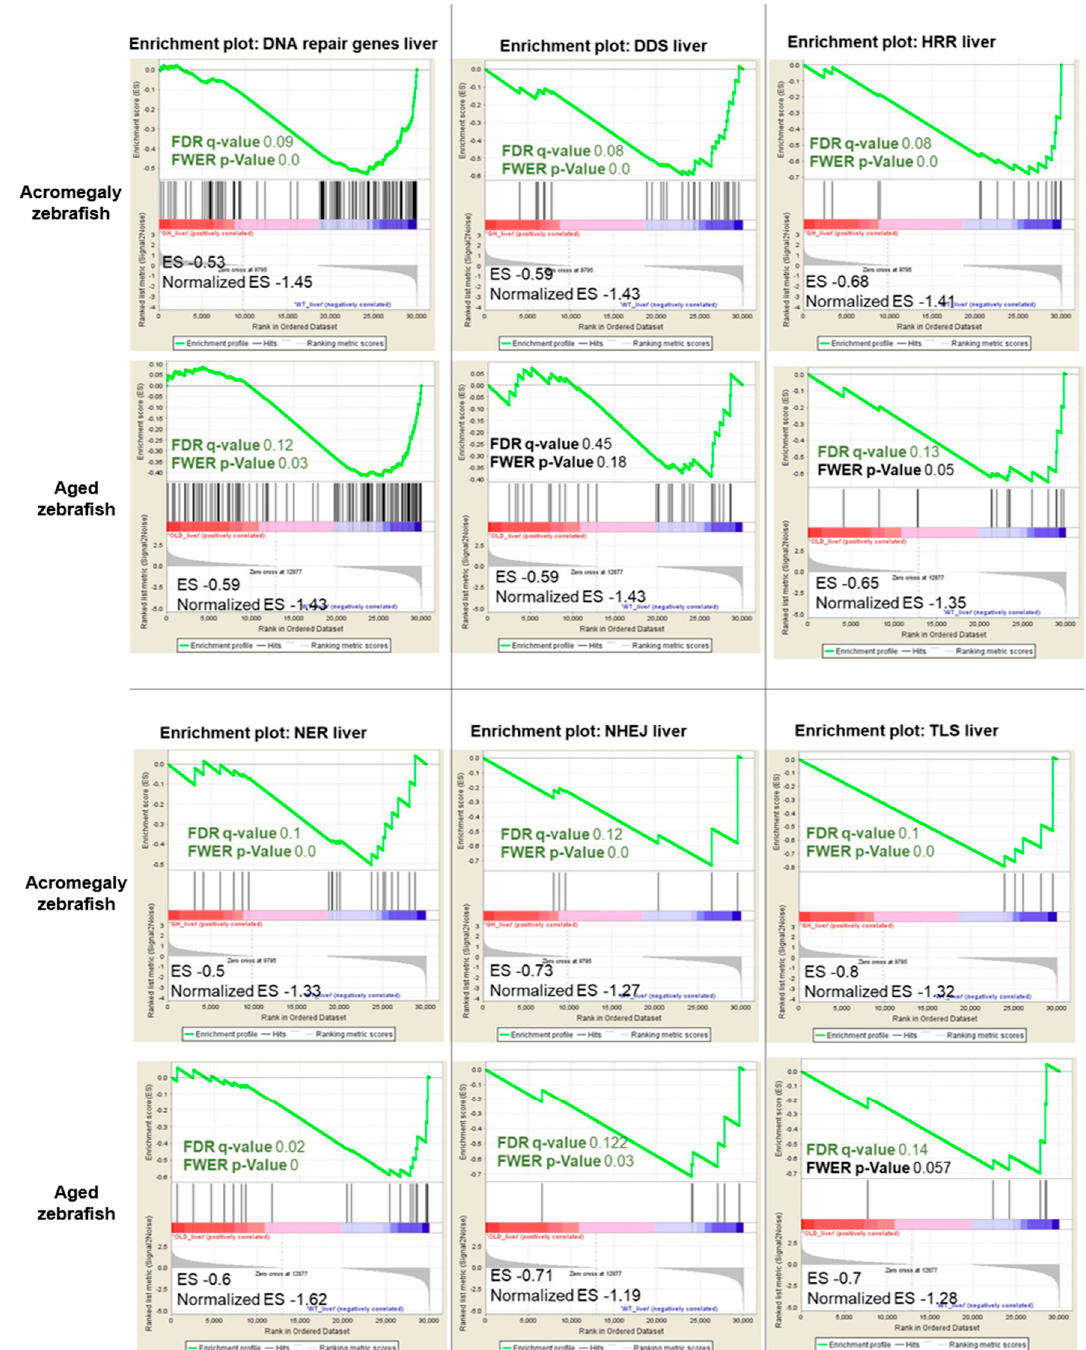
Figure 5. Acromegaly and aged zebrafish impaired DNA repair pathways in the liver. The results of GSEA in acromegaly (one ‐ year ‐ old) and aged zebrafish (three ‐ years ‐ old) liver versus control (one ‐ year ‐ old) showing the familywise ‐ error rate (FWER) p ‐ values, FDR, ES, and normalized ES of DNA repair pathways. Significant p ‐ value < 0.05 and FDR q ‐ value < 0.25 are written in red. According to GSEA [15], the reported p ‐ value of 0.0 indicates an actual p ‐ value of less than 0.01.